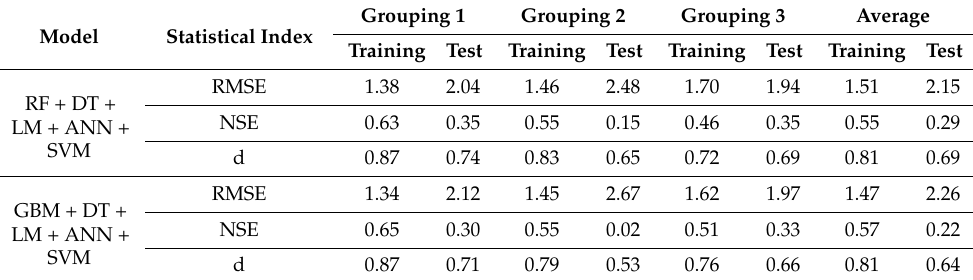
Table 5. Statistical metrics of stacking ensemble models (RF + DT + LM + ANN + SVM and GBM + DT + LM + ANN +